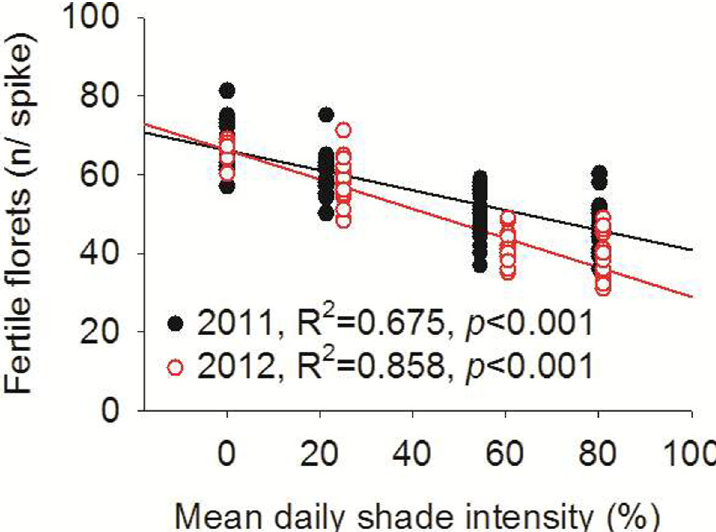
Fig 4. Relationship between the fertile florets and mean daily shade intensity in 2011 and 2012.